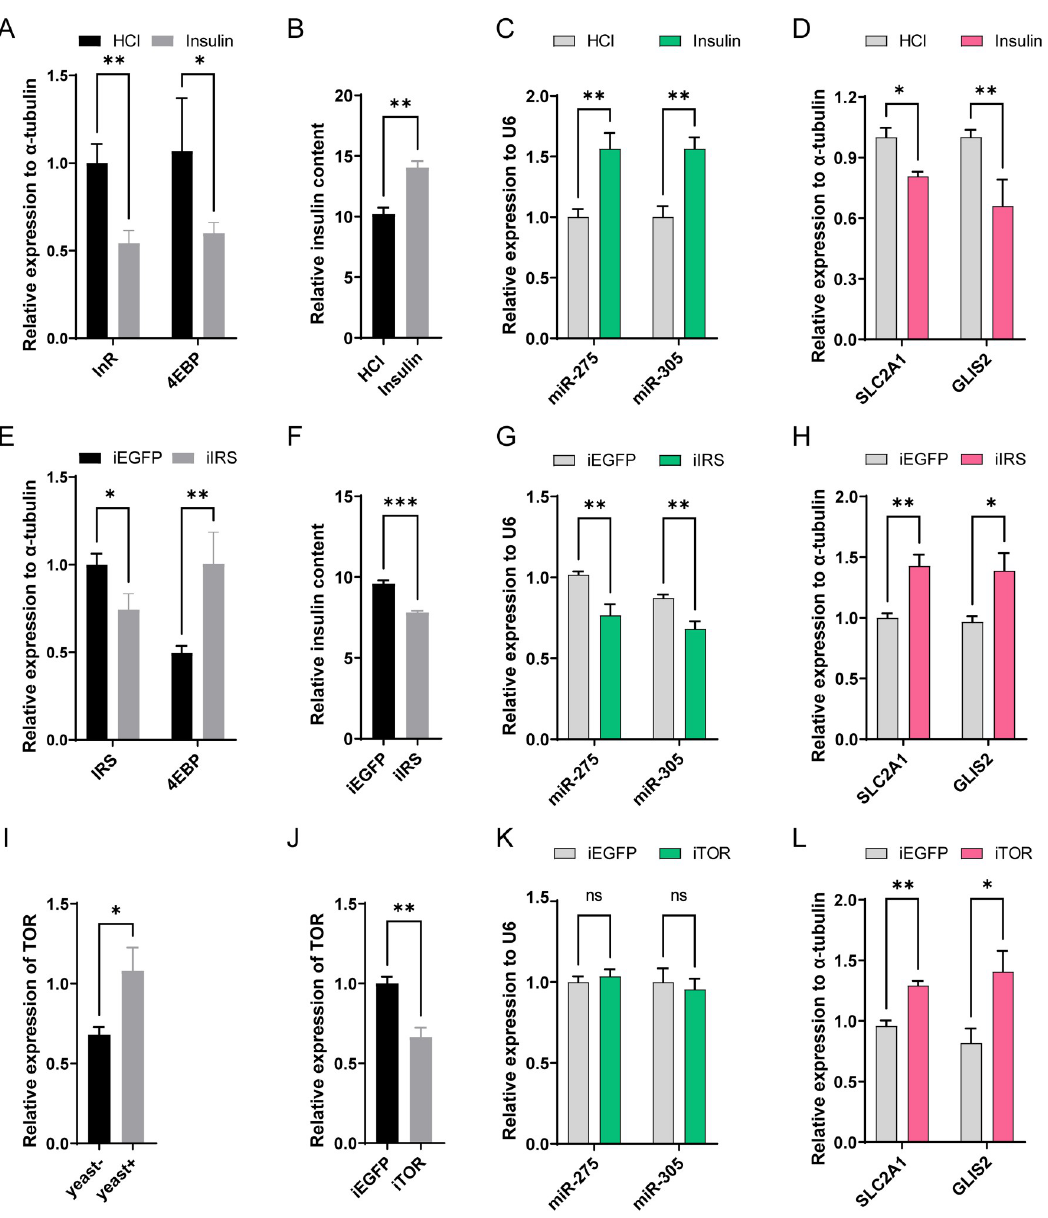
Fig 8. The insulin pathway is involved in the regulation of the miRNA-target axis. (A-D) Effects of enhanced insulin activity on the miRNA-target axis under yeast-rich conditions (yeast+). (A) The relative transcription levels of InR and 4EBP at 24 h post insulin injection. (B) ELISA was employed to quantify the relative insulin content, including the sum of exogenous insulin and insect- produced insulin. (C-D) The relative expression levels of miRNAs (C) and target genes (D) following insulin microinjection. (E-H) Effects of inhibiting the insulin signaling pathway gene IRS on the miRNA-target axis. (E) The relative expression levels of IRS and 4EBP at 2 day post dsIRS treatment. (F) The endogenous insulin titers were detected by ELISA. (G-H) Effects of dsRNA treatment on miRNAs (G) and target genes (H) transcript levels in whole bodies. (I-L) The role of the TOR pathway in the miRNA-target axis. (I) Consumption of yeast-rich foods increases TOR transcription. (J-L) Relative expressions of TOR (J), miRNAs (K), and target genes (L) in the whole bodies at 2 day post dsTOR injection. Data are expressed as means ± SEM. � , P < 0.05; �� , P < 0.01; ��� , P < 0.001 (Student’s